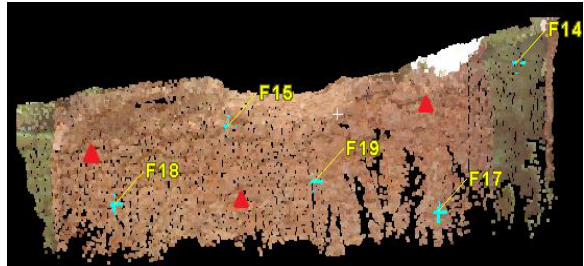
Figure 6. Example of textured point cloud with the reference points – another wall points – another wall points – another wall Reference control points were used in terratriangulation